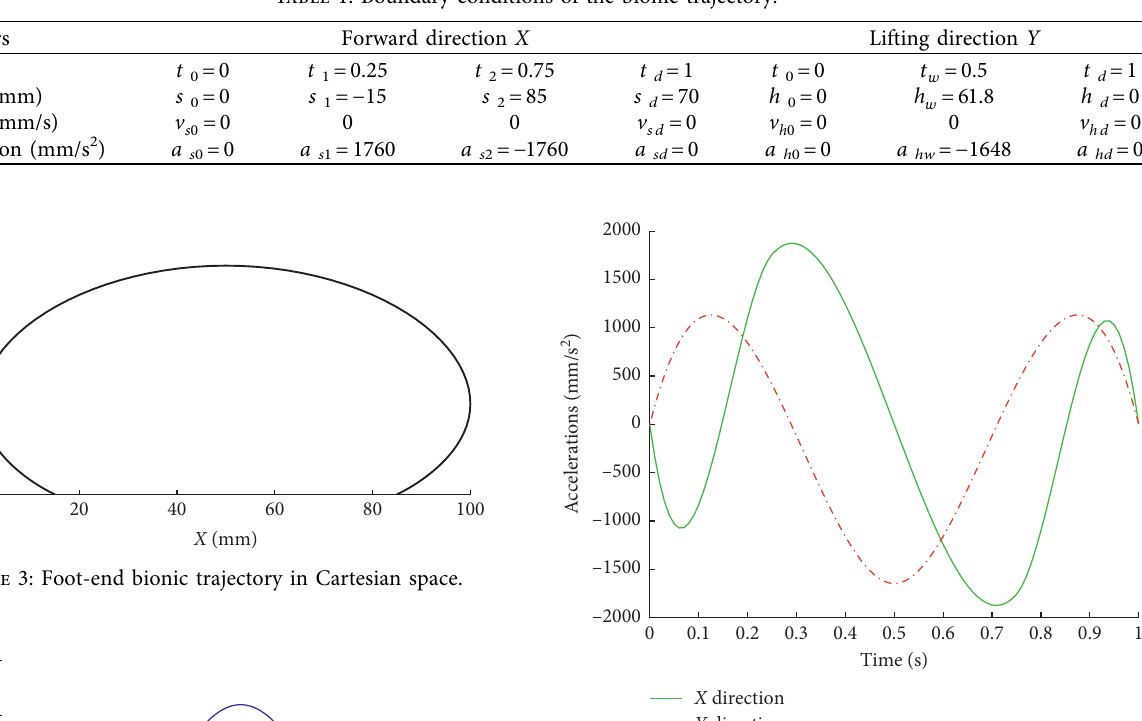
Table 1: Boundary conditions of the bionic trajectory.